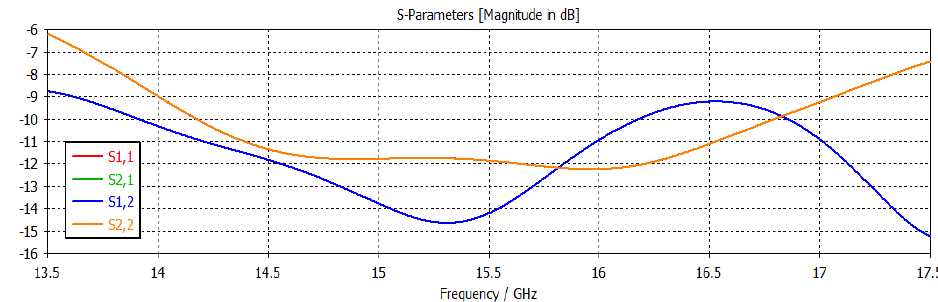
Fig. 3. Simulation results – emitter S-parameters.